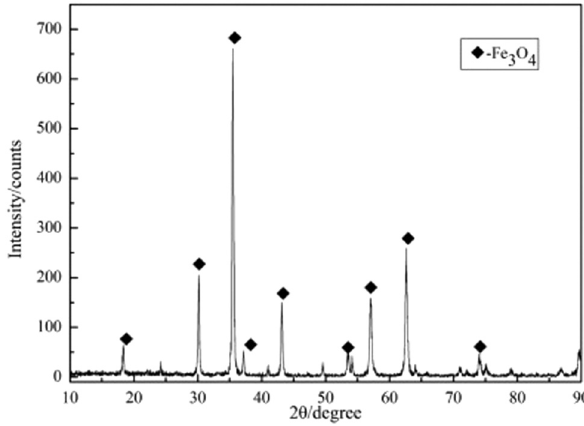
Figure 5: XRD pattern of roasting briquettes at the first